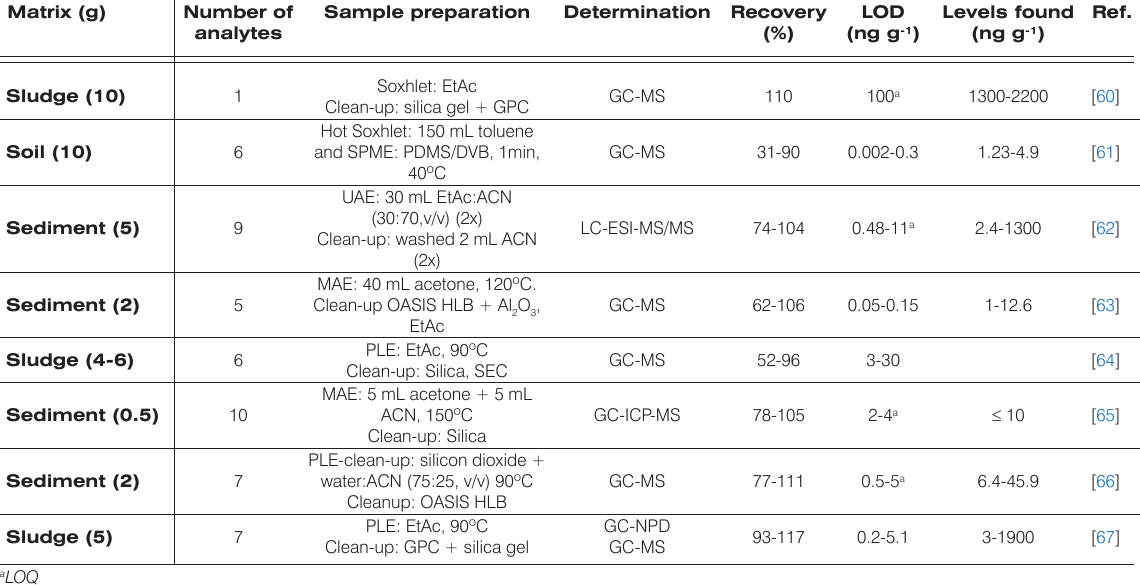
Table 2. Analysis of OPFRs in environmental solid